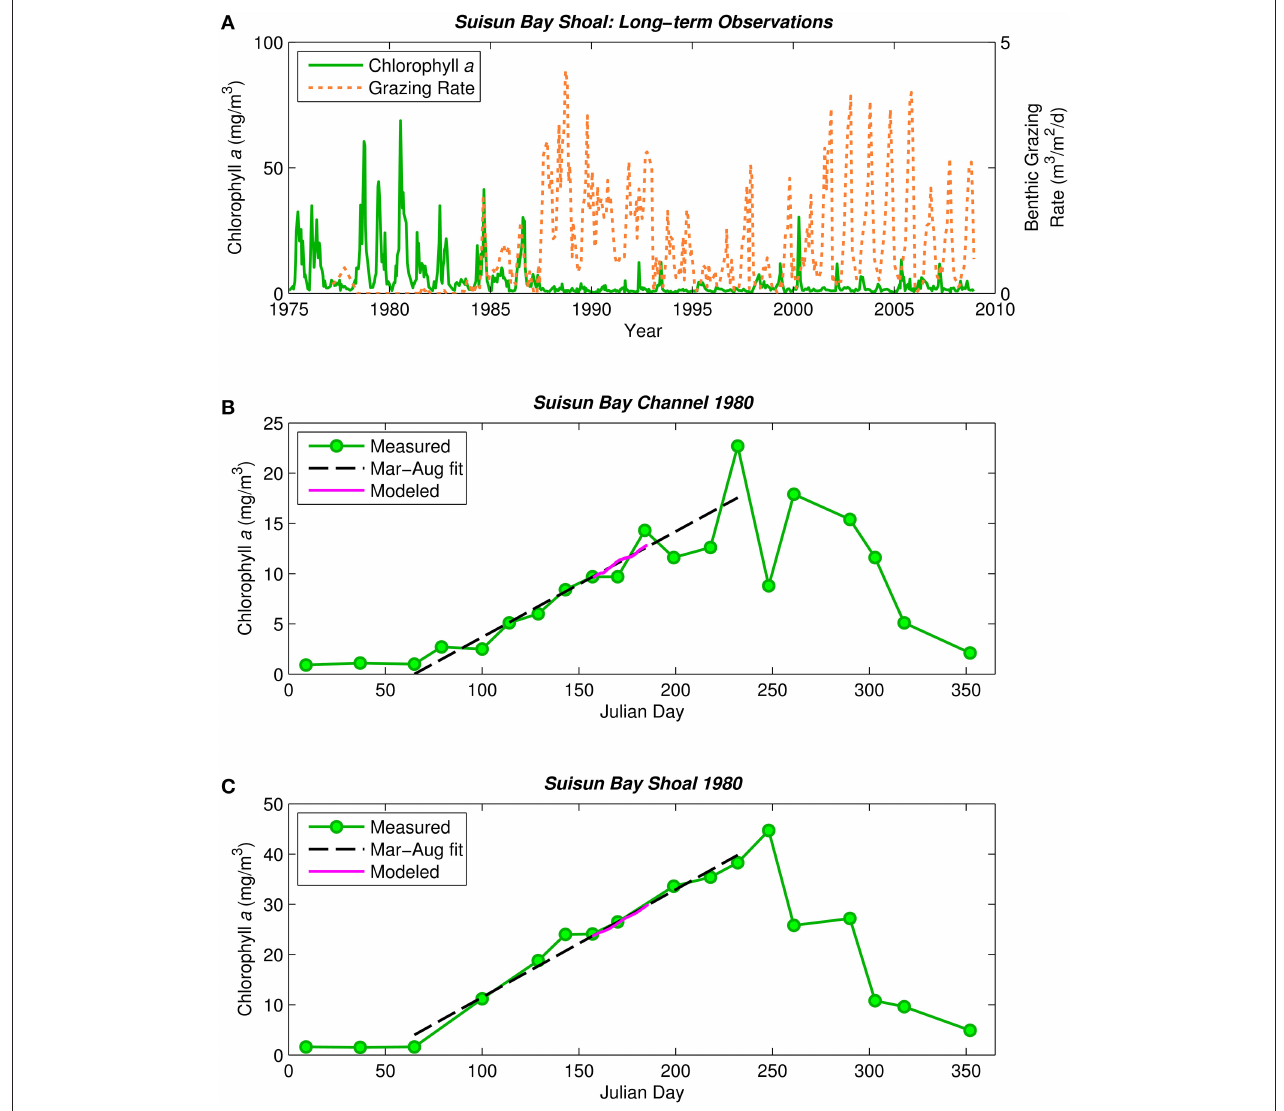
FIGURE 1 | Historical phytoplankton biomass and bivalve grazing rates in Suisun Bay. (A) Phytoplankton biomass (1975–2009, green solid) and benthic grazing rate (1977–2009, orange dashed) in Suisun Bay shallow water. Chlorophyll a is based on water quality samples collected at Station D7 ( Figure 4 ) by the Environmental Monitoring Program of the California Department of Water Resources (CADWR, http://www.water.ca.gov/bdma/meta/). Clam grazing rates were determined by U.S.G.S. analyses of CADWR benthic samples collected at Station D7 and samples collected by the USGS in the 1980’s and 1990’s at a station very close to D7. (B,C) Phytoplankton biomass measured (green) along sampling transects in Suisun Bay channel (B) and shoal (C) during year-long intensive field campaign in 1980 (Cloern et al., 1985). Dashed lines are linear fits to March-August chlorophyll a measurements. Magenta line is chlorophyll a computed by PS2D model for calibrated Suisun Bay “base case.” Computed channel chlorophyll values shown are averaged over the top 2m of the water column and centered daily averages. Computed shoal chlorophyll values shown are